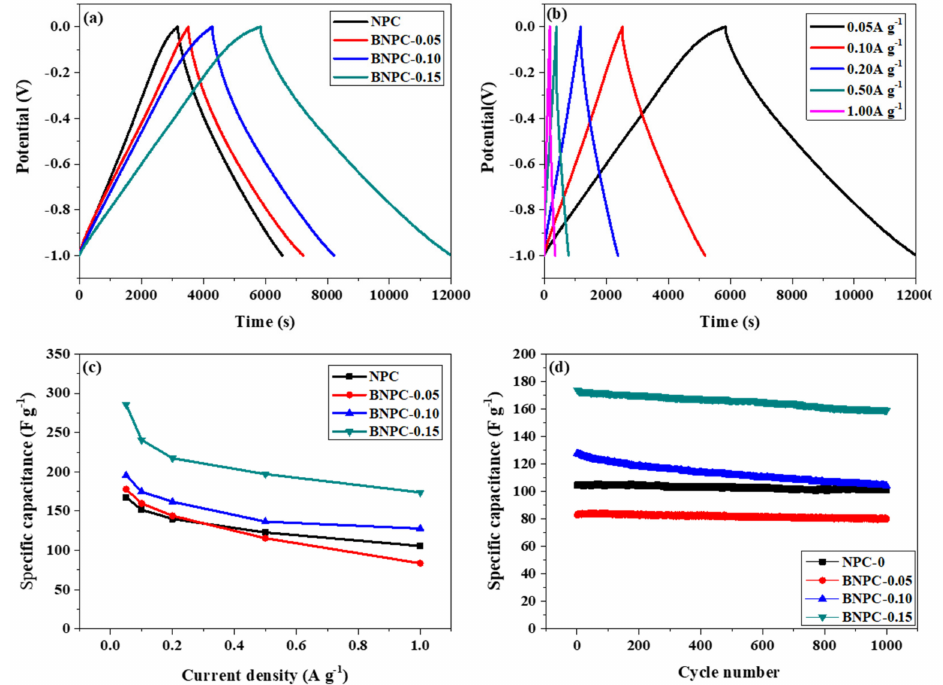
Figure 5. Galvanostatic charge–discharge (GCD) curves of the NPC and BNPC-X at a current density of 0.05 A · g − 1 ( a ), GCD curves of the BNPC-0.15 at di ff erent current densities ( b ), the specific capacitances of the NPC and BNPC-X at di ff erent current densities ( c ), and the cycling stability of the NPC and BNPC-X at a current density of 1 A · g − 1 ( d